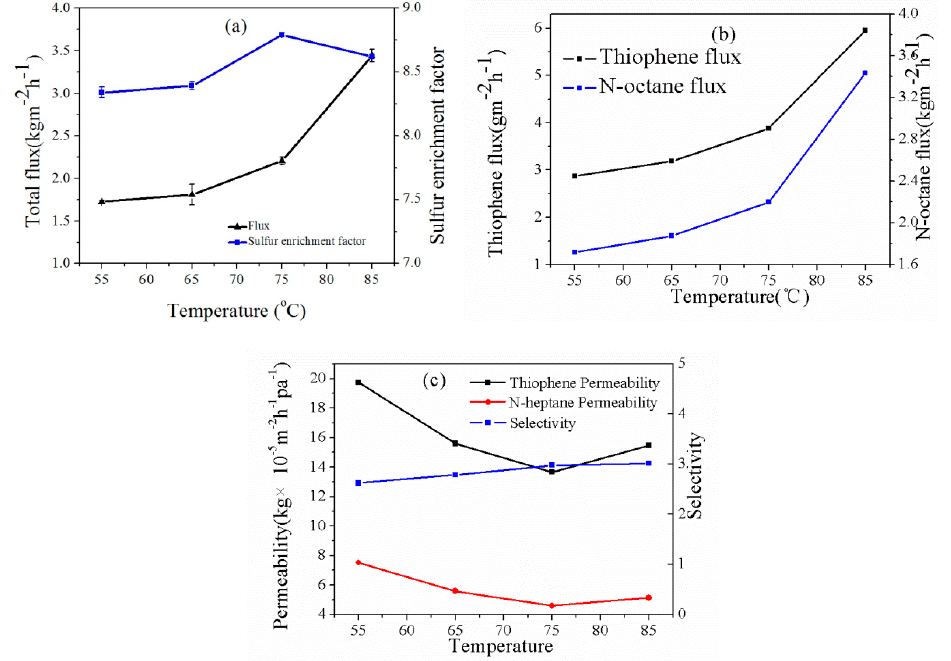
Figure 8. Effect of feed temperature on ( a ) total flux and sulfur enrichment factor; ( b ) thiophene flux and n -octane flux; and ( c ) permeability and selectivity of the CuBTC-filled PEG MMMs.